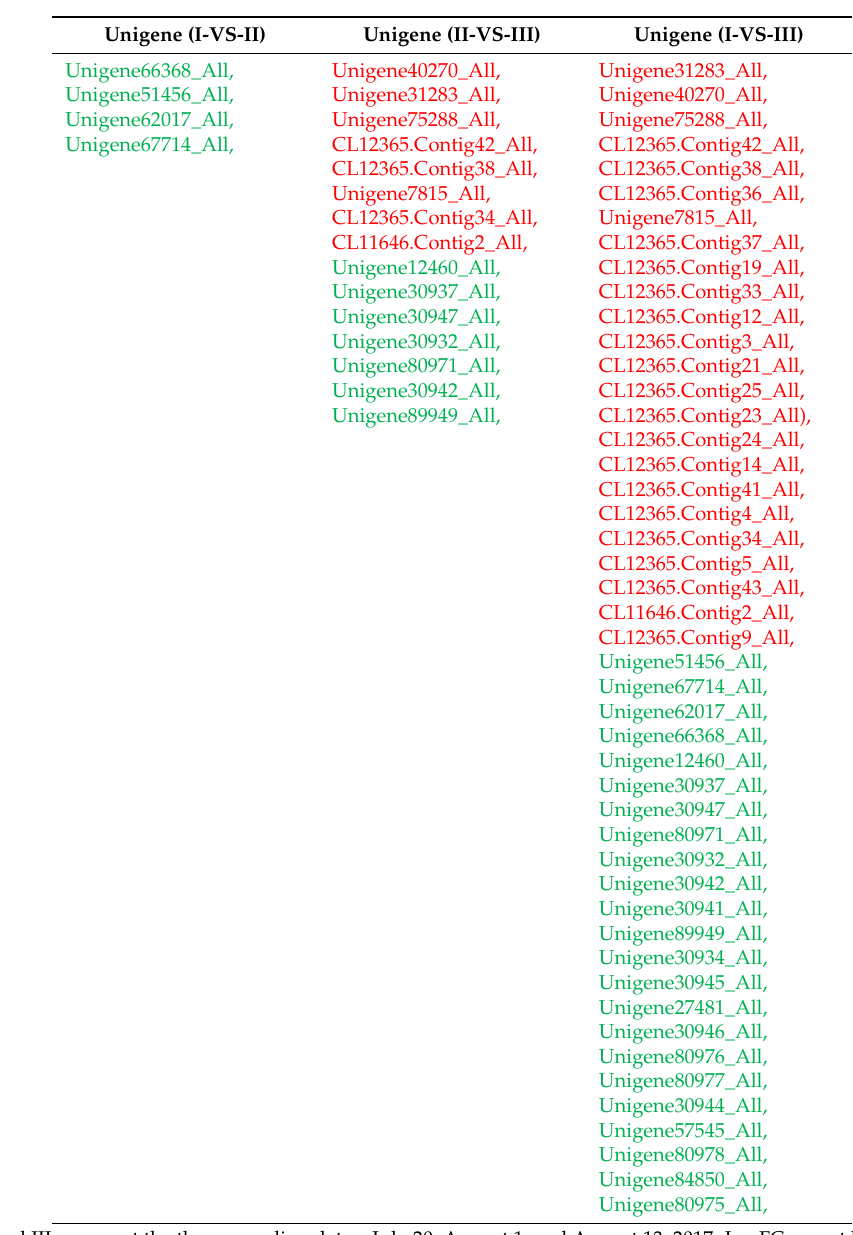
Table 2. List of di ff erentially expressed sucrose synthase [2.4.1.13]